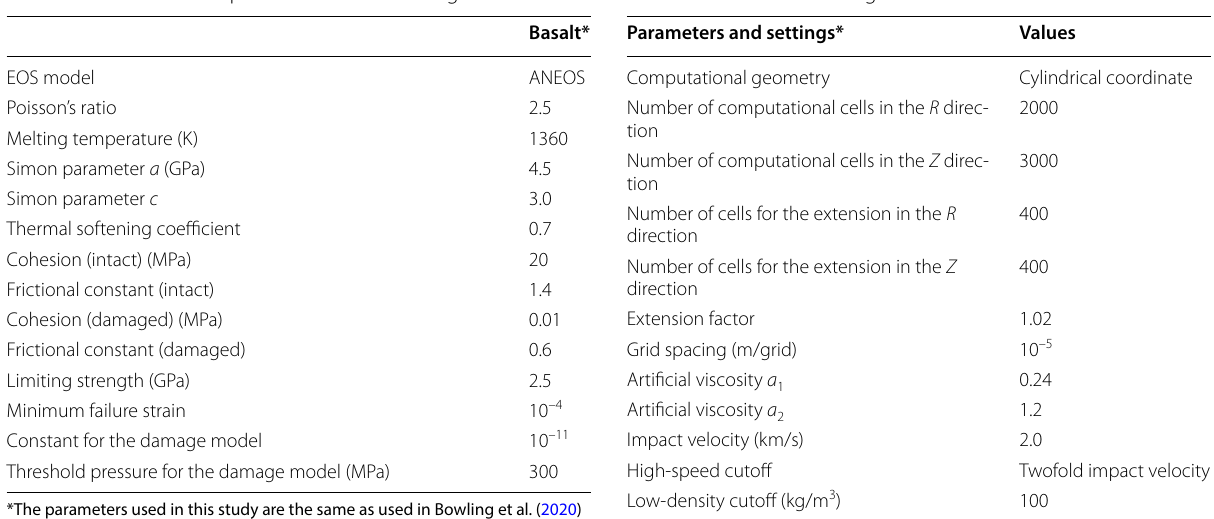
Table 3 Material model parameters for basalt